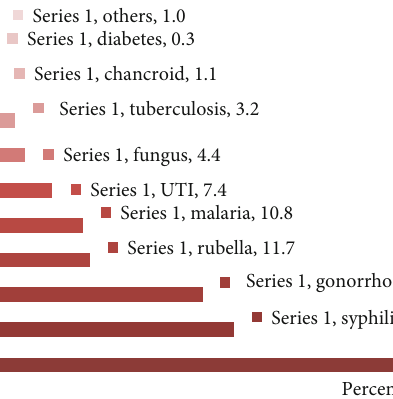
Figure 1: Conditions and/or infections mentioned by women that can be transmitted from mother to child in Kilimanjaro ( N = 618